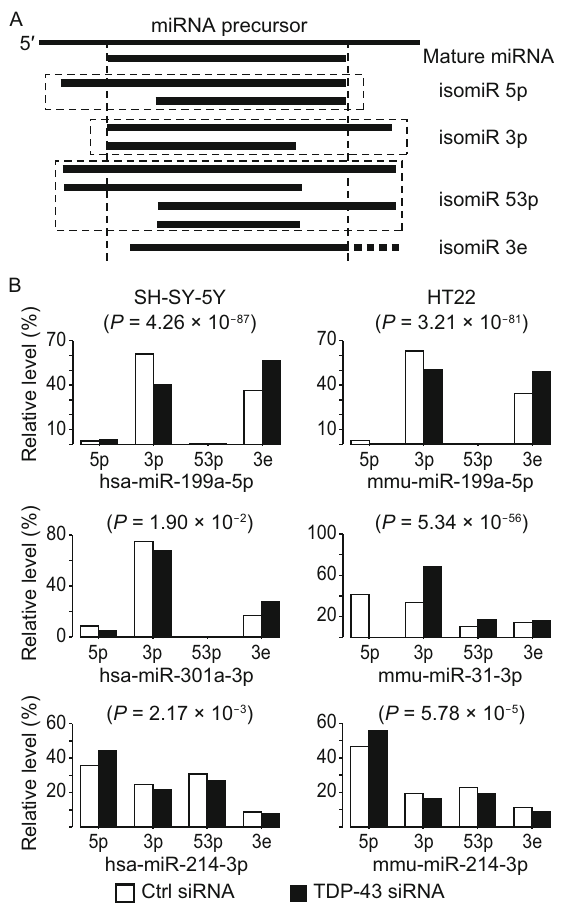
Figure 2. TDP-43 knockdown leads to changes in miRNA isoform patterns. (A) De fi nition of isomiR types. (B) IsomiR pattern alterations of hsa-miR-199a-5p, mmu-miR-199a-5p, hsa-miR-301a-3p, mmu-miR-31-3p, hsa-miR-214-3p, and mmu-miR-214-3p